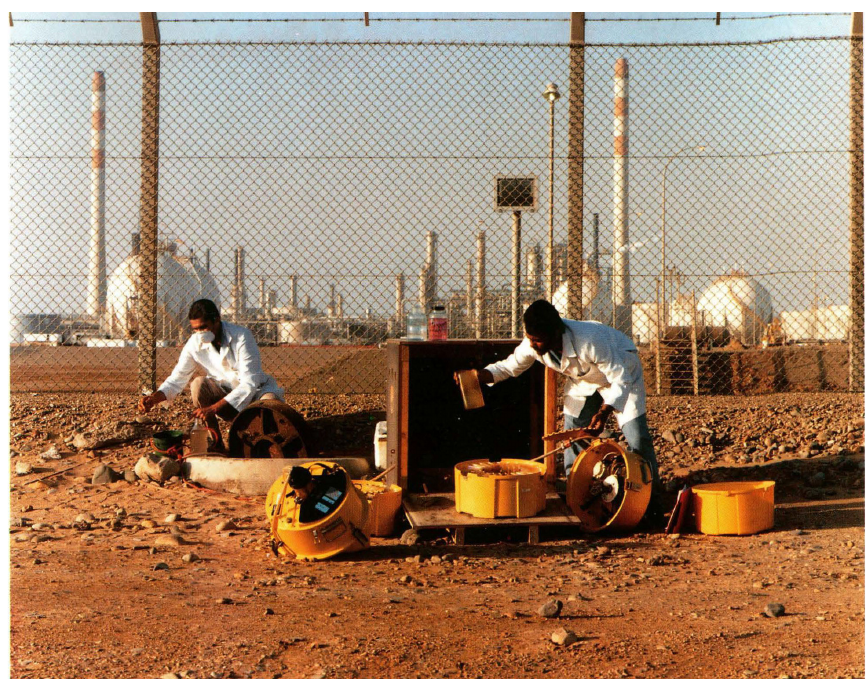
Technicians collecting samples from air monitoring